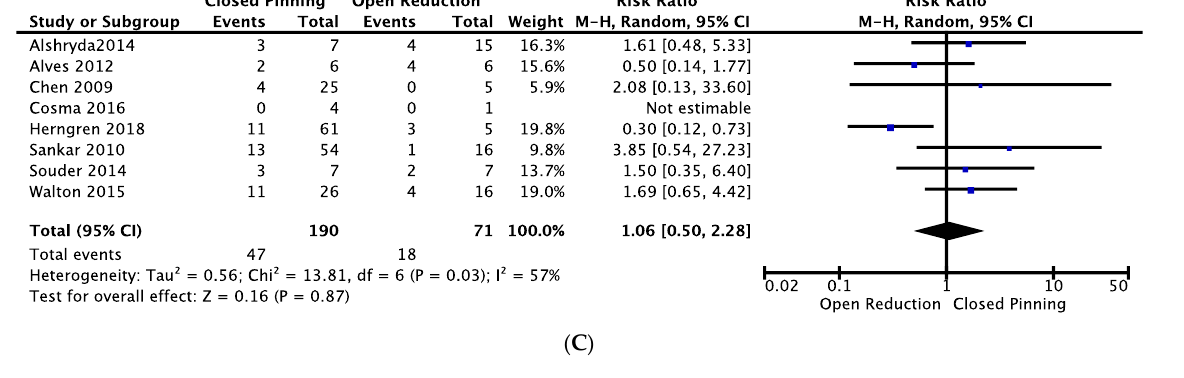
Figure 2. Prevalence ( A , B ) and risk ( C ) of developing avascular necrosis following closed pinning and open reduction in patients with unstable slipped capital femoral epiphysis. ( A ) Closed pinning. ( B ) Open reduction. ( C ) Estimated risk ratio in closed pinning versus open reduction. Table 2. Subgroup analyses of prevalence.